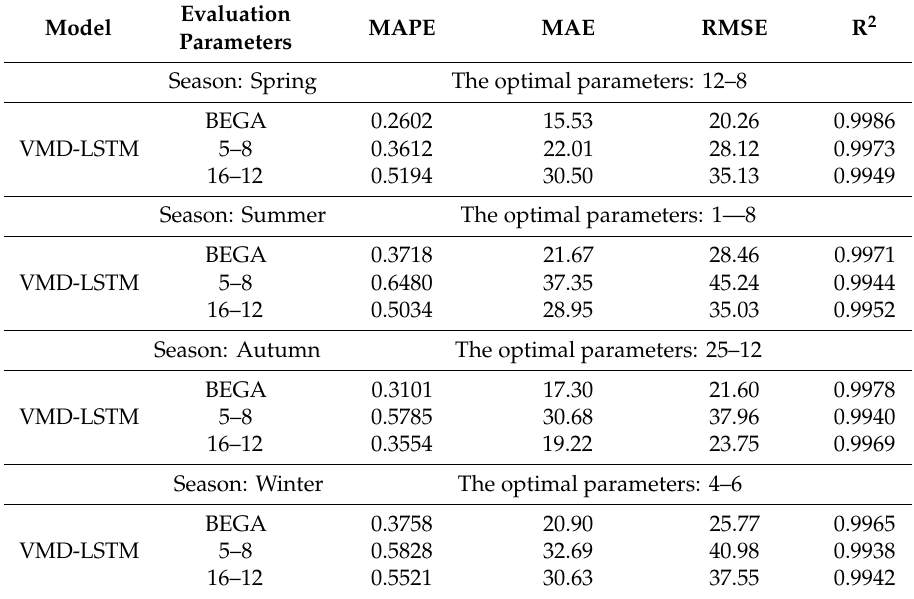
Table 11. Comparison of the results for di ff erent input unit lengths and numbers of cell units based on the NSW seasonal